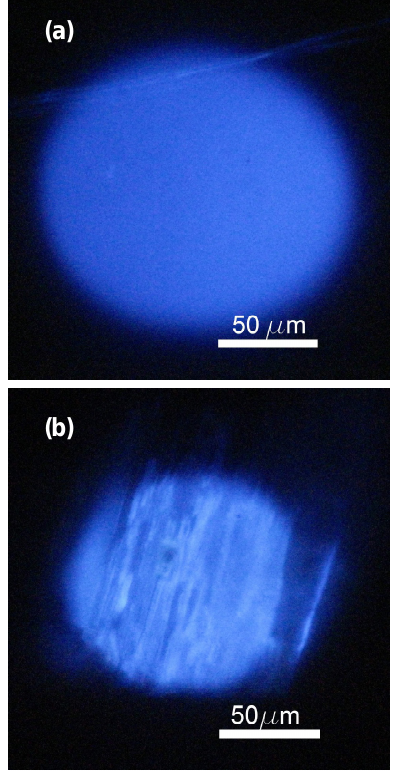
Fig. 3. Cathodoluminescence images of the surface of the studied  -Ga from (100) (a) and (010) (b)